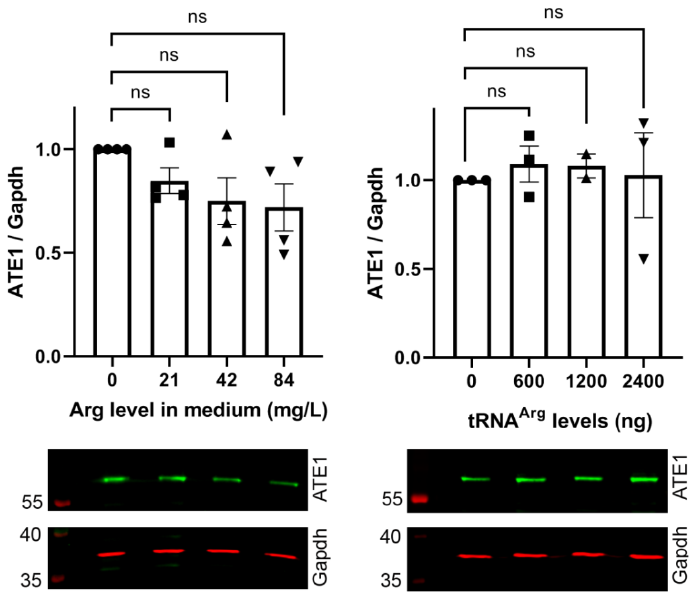
Figure 5. Addition of free Arg or tRNA Arg to cells does not affect the levels of ATE1. Charts ( top ) and representative Western blot images ( bottom ) of sensor-based quantification of arginylation in cells grown in media supplemented with different amounts of Arg ( left ) or transfected with different amounts of tRNA Arg ( right ). Error bars represent SEM, at least n = 3 independent transfections; ns, not significant, Welch’s t